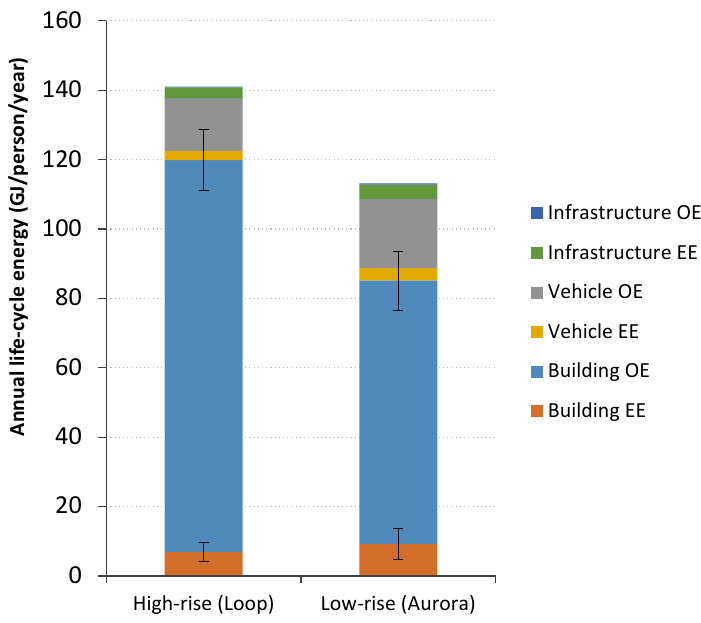
Figure 9. Annual life-cycle energy (GJ/person/year) associated with residential life in high-rises in the downtown Chicago Loop and low-rise residences in suburban Aurora,